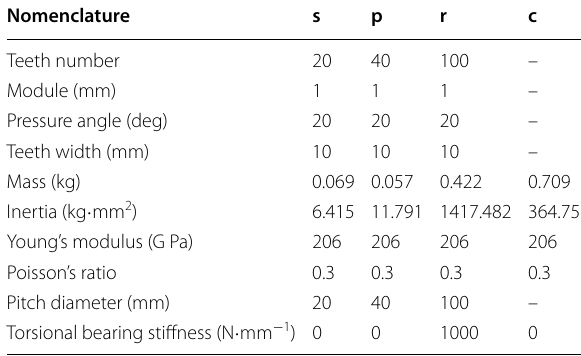
Table 1 Parameters of the dynamic